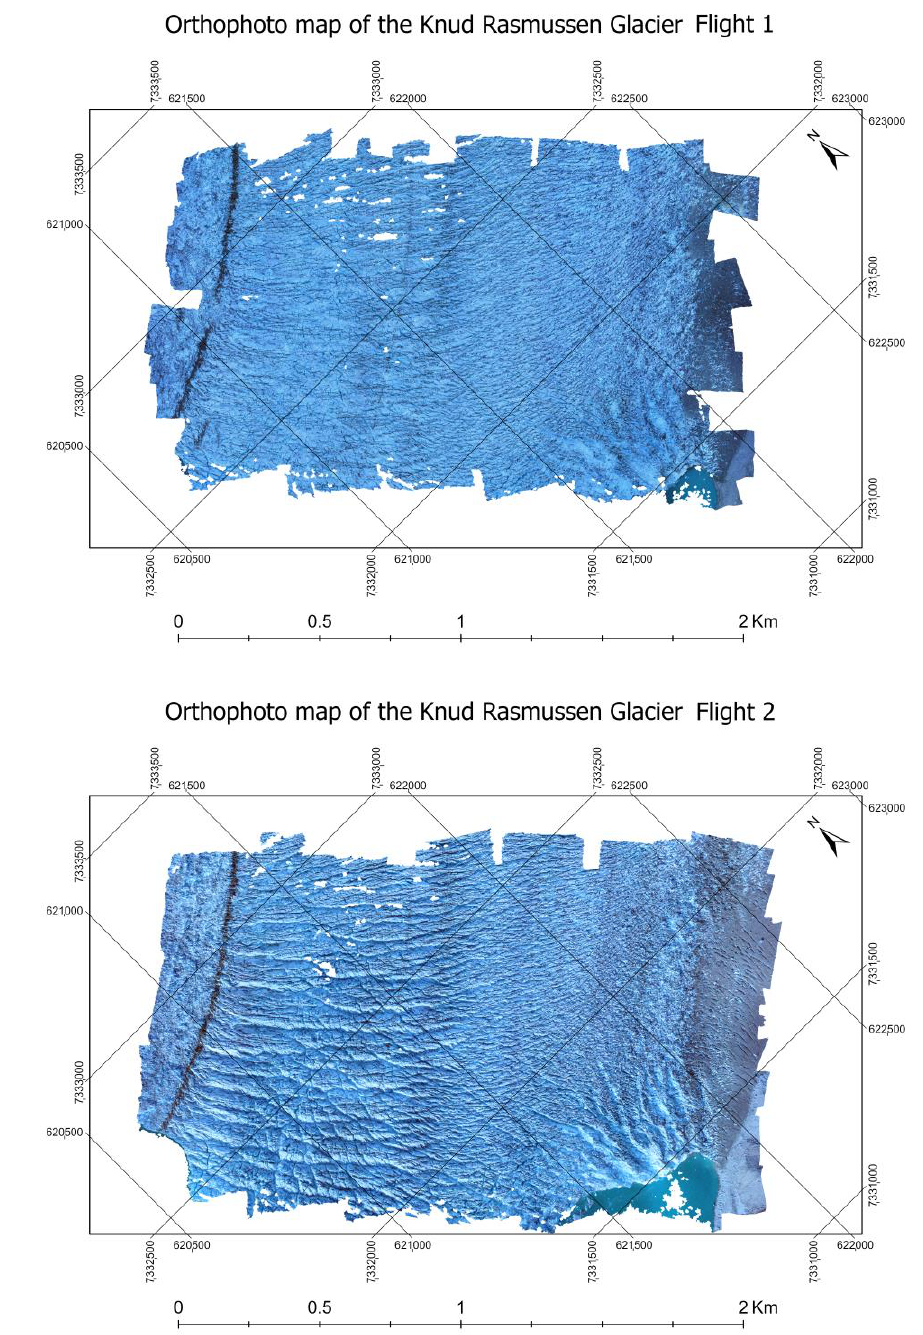
Figure 10. Flight no.1 and flight no.2 (orthophoto in near infrared range). On the second orthophoto there are shadows, which make the picture more plastic.